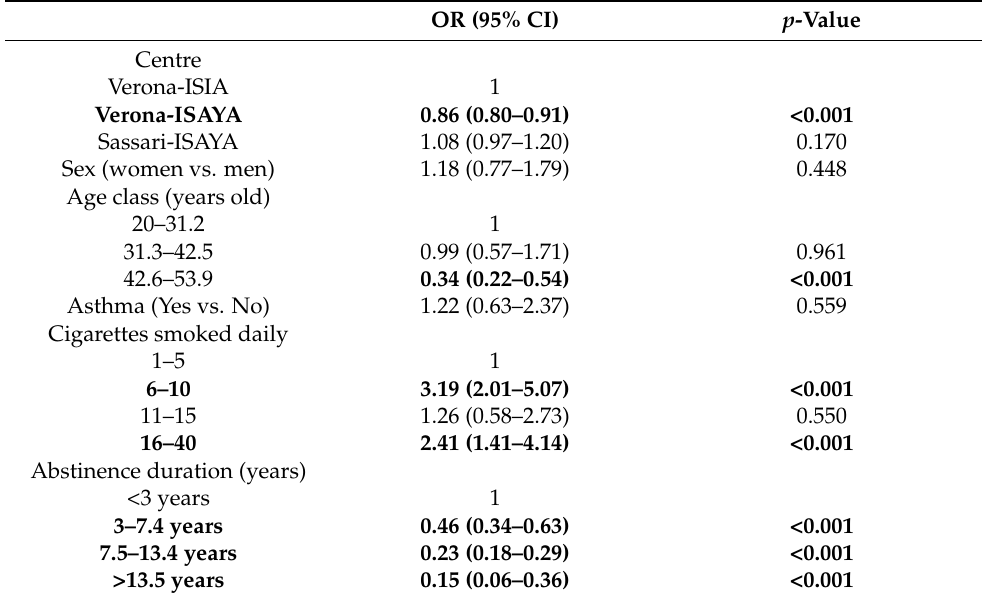
Table 5. The influence of socio-demographic characteristics, respiratory disorders, baseline smoking intensity, and abstinence duration on smoking